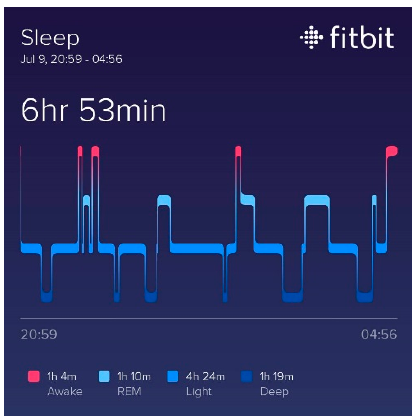
Figure A20. Hanoi, Vietnam.